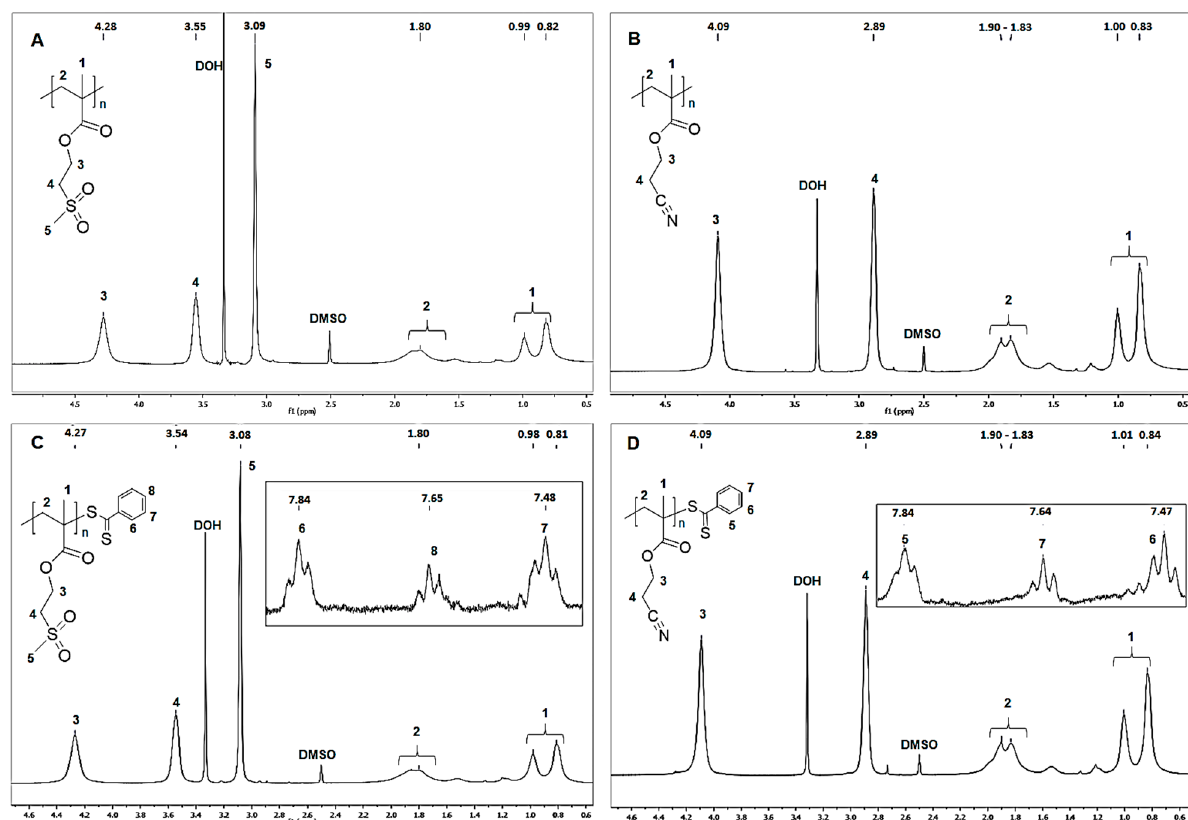
Figure 2. 1 H-NMR spectra of both polymethacrylates polymerized conventionally ( A , B ) and by RAFT methodology ( C , D ). DMSO-d 6 used as solvent.